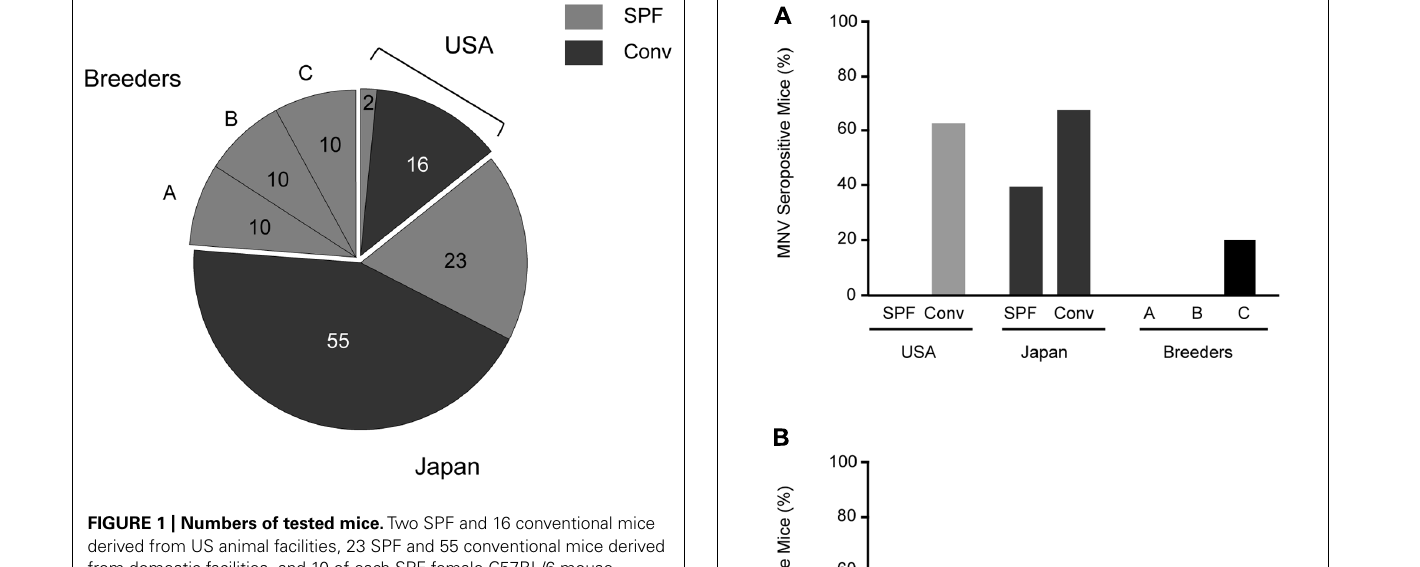
despite their disparate geographic locations across the country.